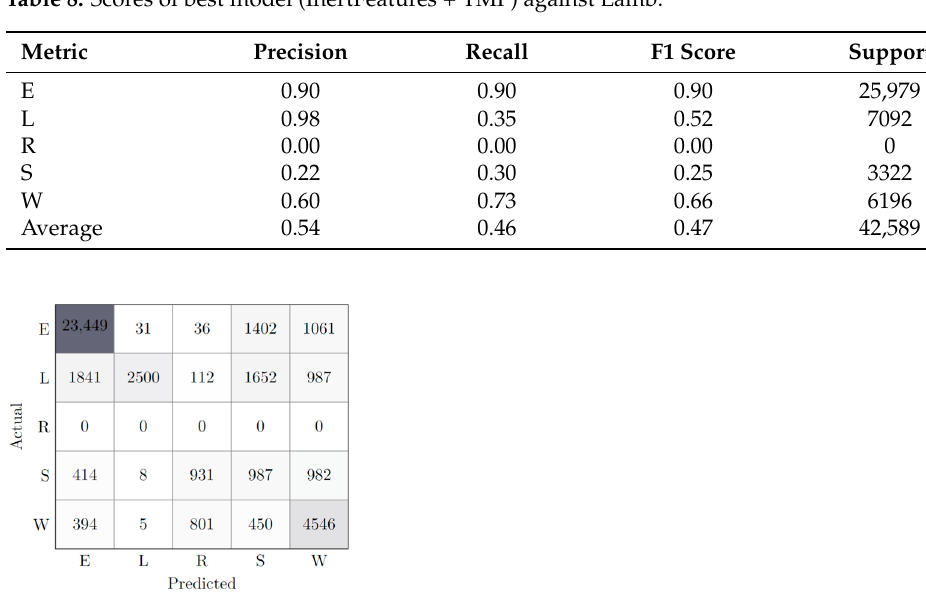
Figure 7. Performance of Best Model (InertFeatures + TMP) against Lamb. The different cell colors represent the classification accuracy; the more accurate the classification of a state, the darker the cell is represented.